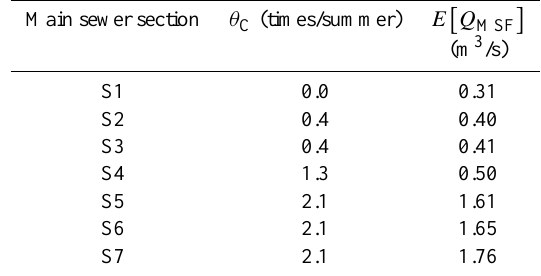
Maximum flow. Main sewer section S7. Table 1. Diagnosis results for the main